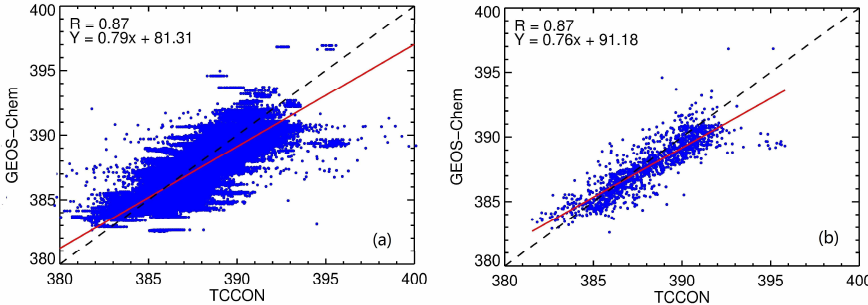
Figure 16. The scatter plots between XCO 2 from TCCON sites and GEOS-Chem (( a ) using averaging kernels without considering the spatial support; ( b ) using averaging kernels and then calculating the average) in 2010. Table 6. Comparison between XCO 2 from GEOS-Chem and TCCON sites in 2010. XCO 2 R Bias (using averaging kernels and no